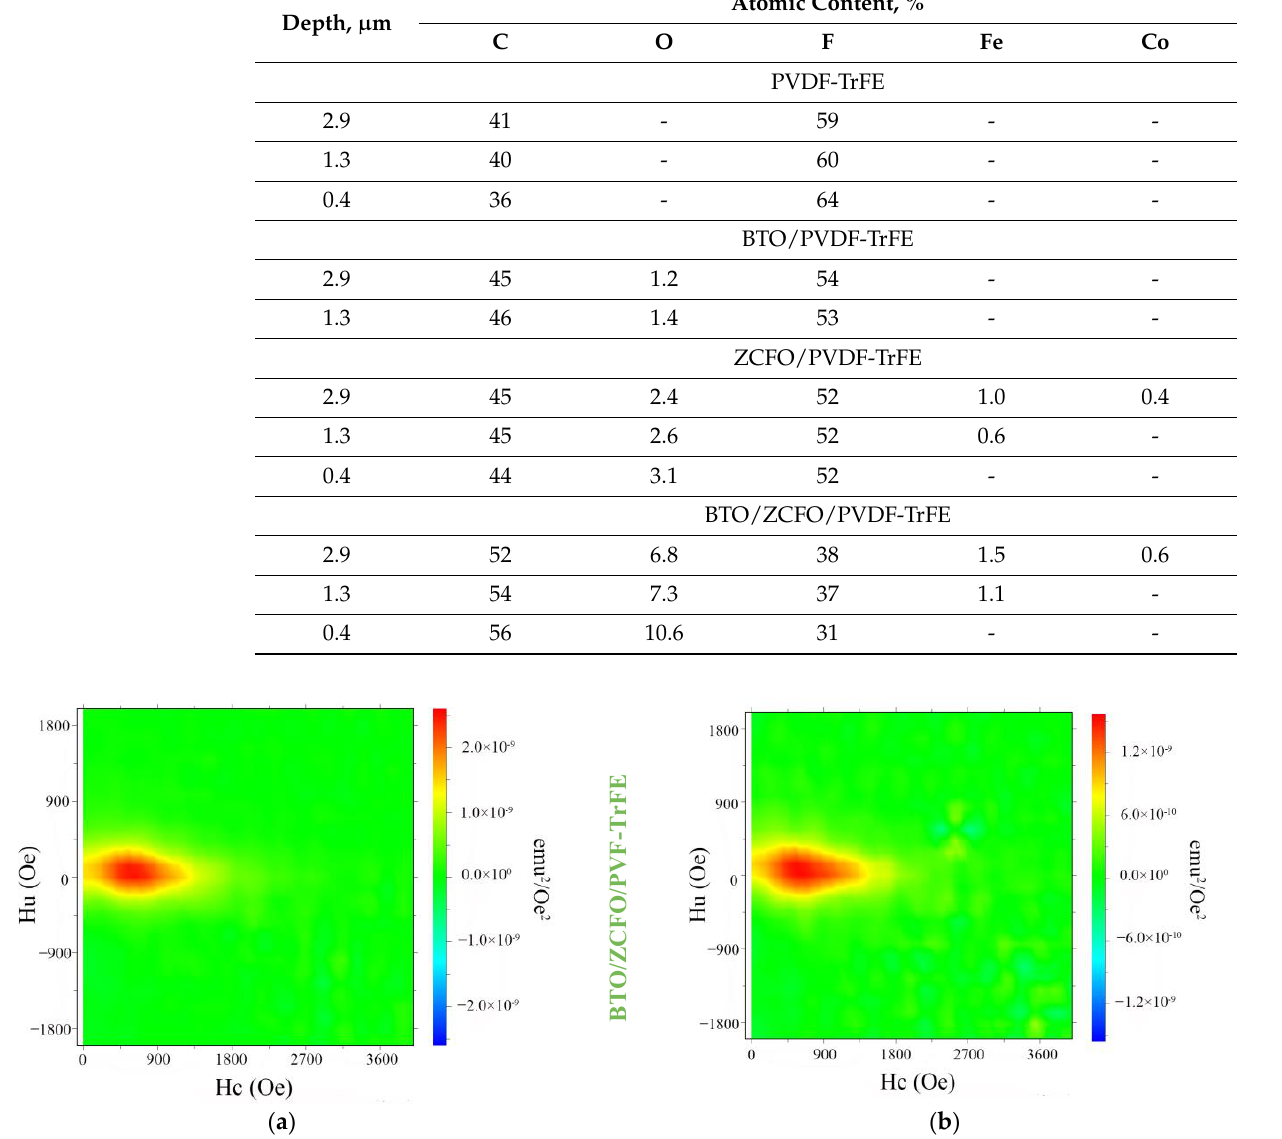
Figure 4. FORC diagrams of ZCFO/PVDF-TrFE ( a ) and BTO/ZCFO/PVDF-TrFE ( b ) composite samples.